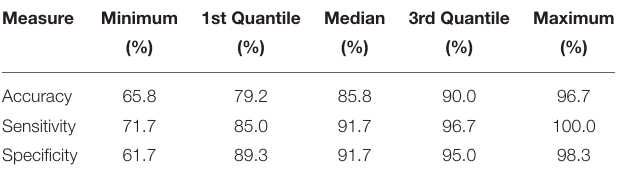
TABLE 2 | Performance of the classifier averaged over 100 five-fold cross validation runs balanced with bootstrapping for the test set (with ) using SQI2, PSD ratio, and sample entropy (SQI2,PSD, H s ) as features.